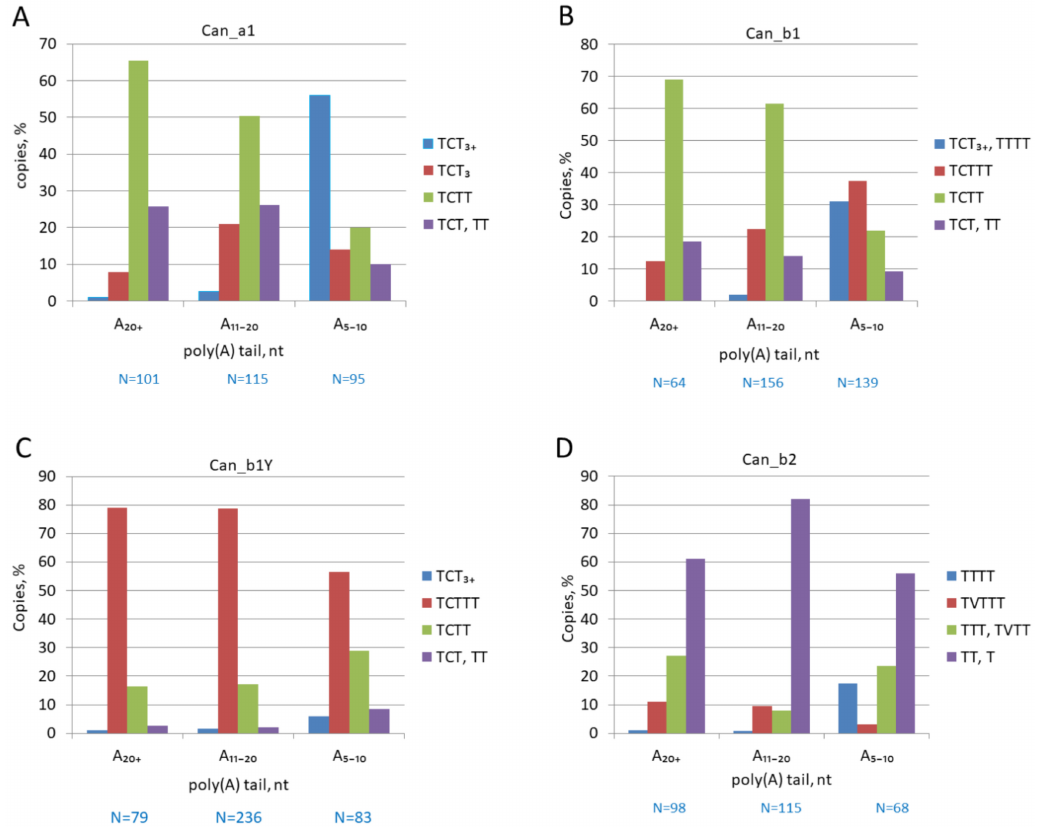
Figure 5. Distribution of pol III terminators or their rudiments among Can copies with poly(A) tails of different lengths. ( A ) Can_a1 subfamily; ( B ) Can_b1 subfamily; ( C ) Can_b1Y, young b1 copies; ( D ) Can_b2 subfamily. The number of analyzed Can copies is indicated below as N = number. V in terminator sequences corresponds to C, A, or